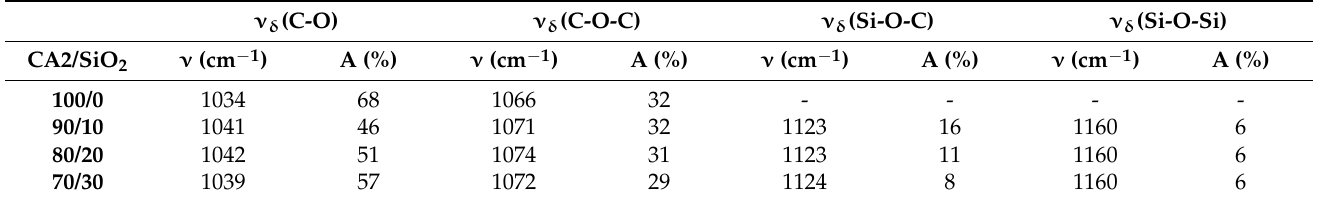
Table 3. Series two: frequency ( ν ) and relative area (A %) of the bands ν δ (C-O), ν δ (Si-O-Si), and ν δ